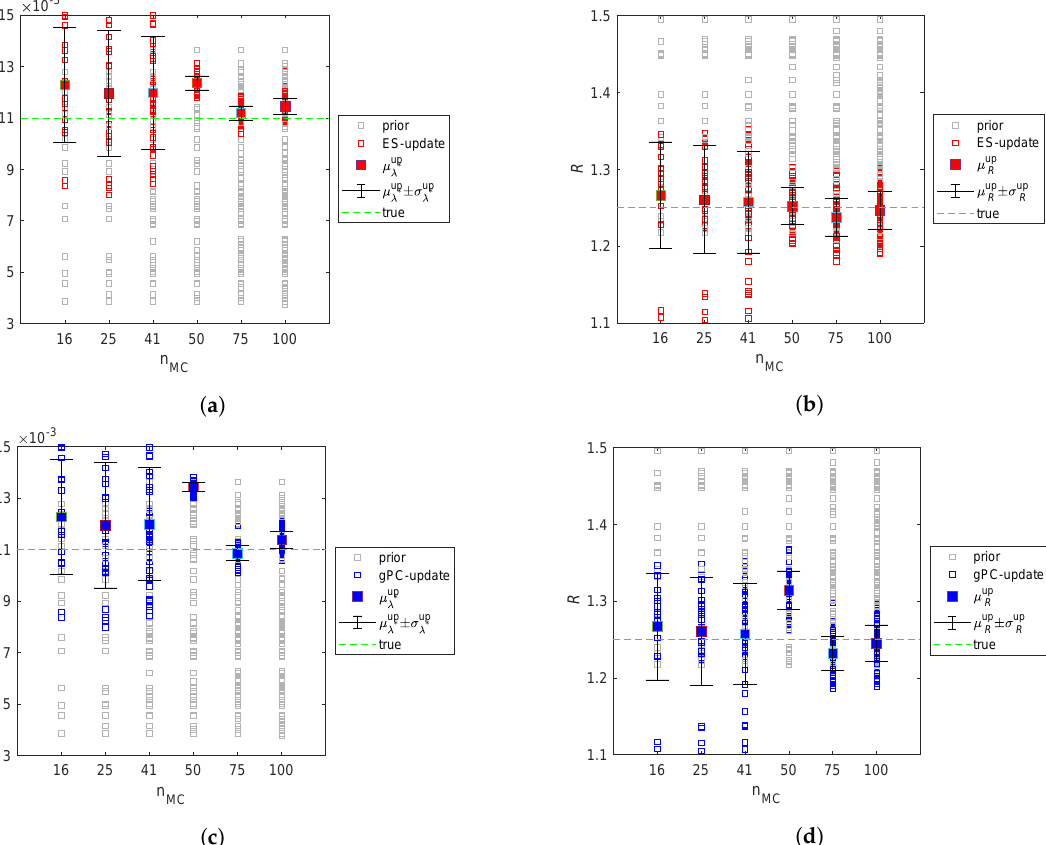
Figure 4. Parameter ensembles for increasing number of Monte Carlo realizations n MC . Panels ( a ) and ( b ) use the standard Ensemble Smoother (ES) with the full forward model for λ ∗ and R , respectively. Panels ( c , d ) provide the same outcome as ( a , b ) by using the gPCE-ES approach. µ and σ are the mean and standard deviation of the updated (up)